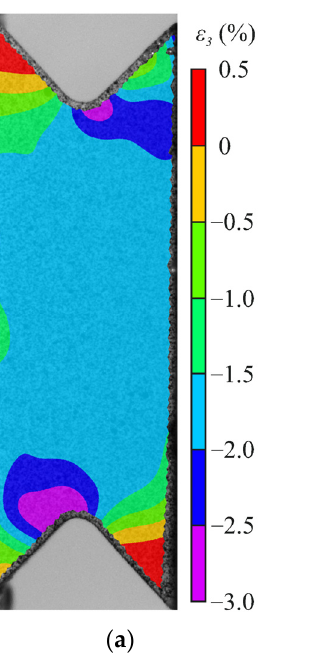
Figure 12. Distribution of through-thickness strains at α = 20°: ( a ) on the face surface of the specimen under load 42 kN, ( b ) on the face surface of the specimen under load 55 kN, ( c ) between the notches.